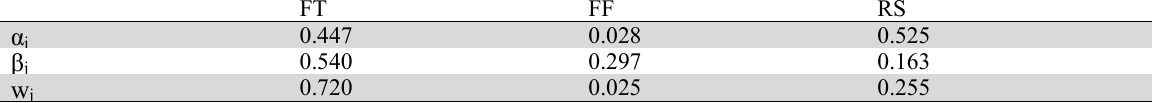
Criteria weighting by the Entropy ( α j ), AHP ( β j ) and compromised weighting (w j ) methods